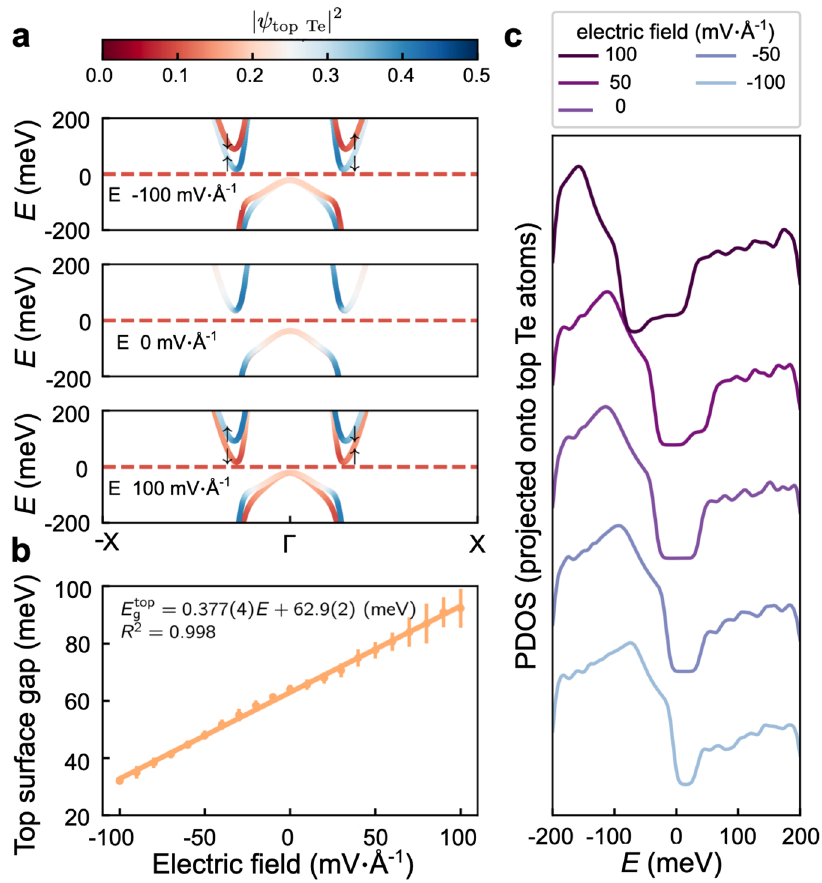
Fig. 5 Tight-binding calculations of the band structure and gating response of ML-WTe 2 . a Band structure for − 100, 0 and 100 mV Å − 1 electric fi elds. We estimate that a gate voltage of 80 V corresponds to ~100 mV Å − 1 The bands are colored with blue or red to represent electronic states that are more localized at the top Te atoms or the bottom Te atoms, respectively. The small black arrows indicate the spin polarization of the bands (near the band bottoms) due to the electric fi eld from the applied gate voltage. b The computed gap at the top surface plotted versus the electric fi eld. The slope and values are in close agreement with the STM data. c Projected density of states (PDOS) with different gate voltages. The PDOS represents the density of states projected onto the top Te